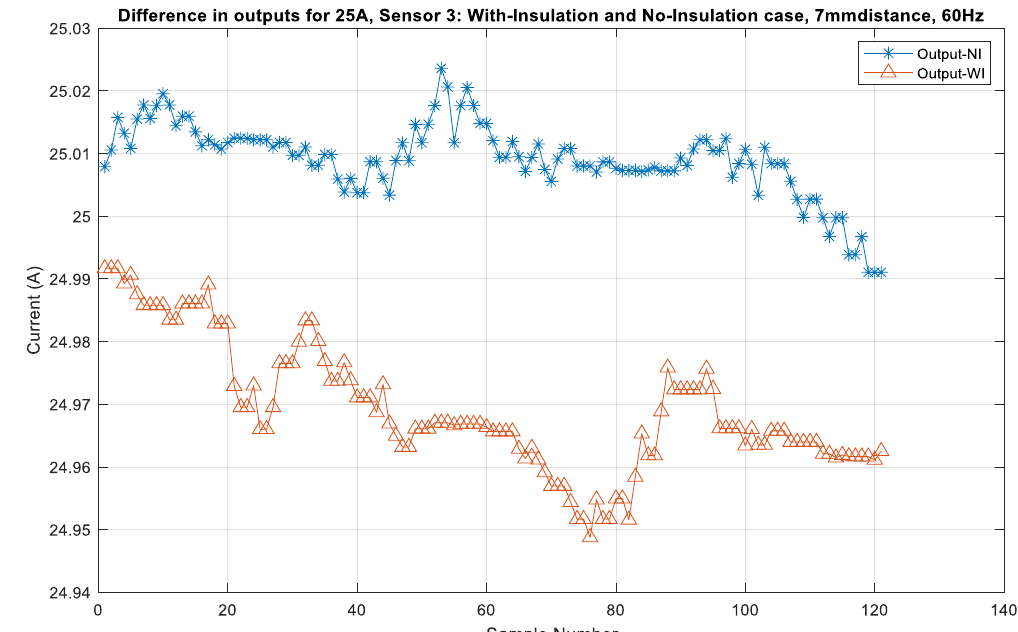
Figure 12. Sensor S5 outputs for currents of 5 A to 25 A: WI and NI cases.